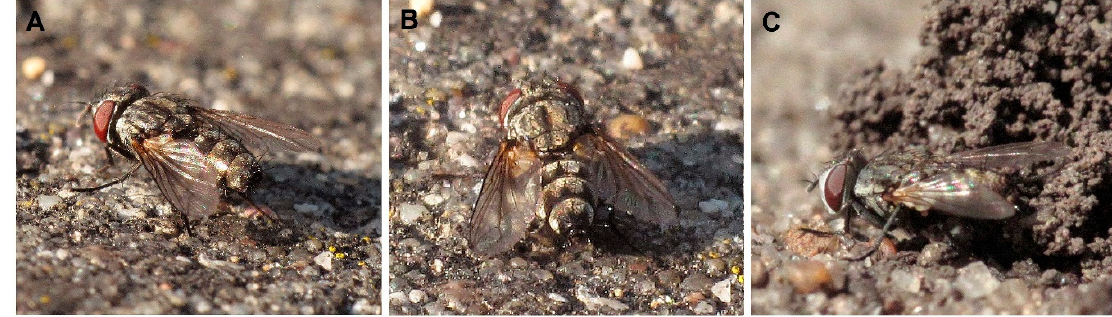
Figure 4. Kleptoparasites. ( A , B ) Females of Metopia argyrocephala; ( C ) female Senotainia conica.